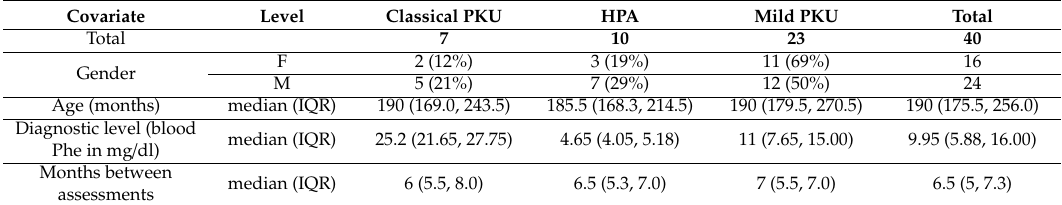
Table 1. General subject characteristics.